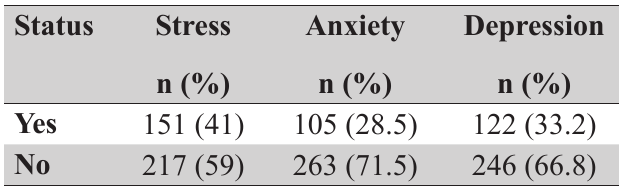
Table 3. Prevalence of stress, anxiety and depression among the participants (n=368).